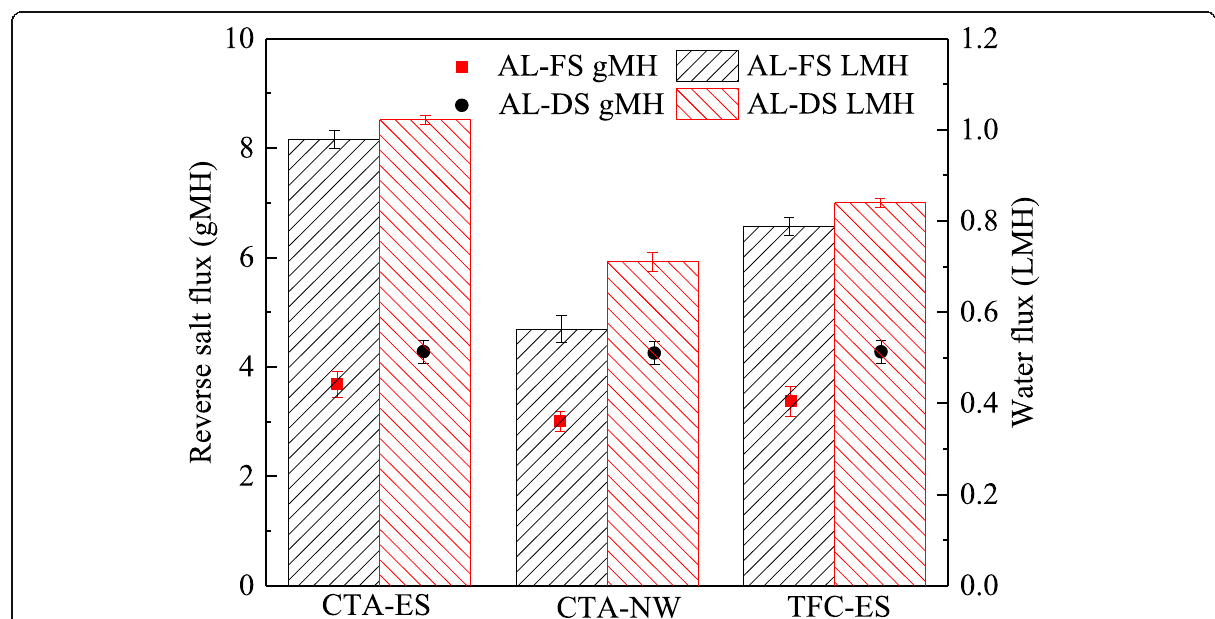
Fig. 2 Water flux and reverse salt flux for OsMFCs under both